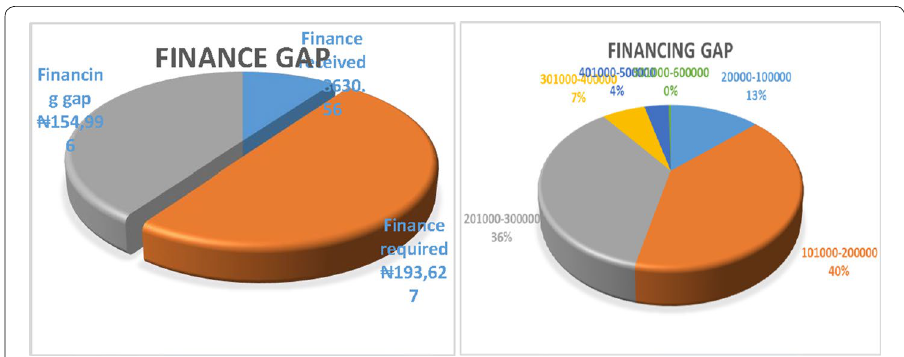
Fig. 2 Financing gap analysis